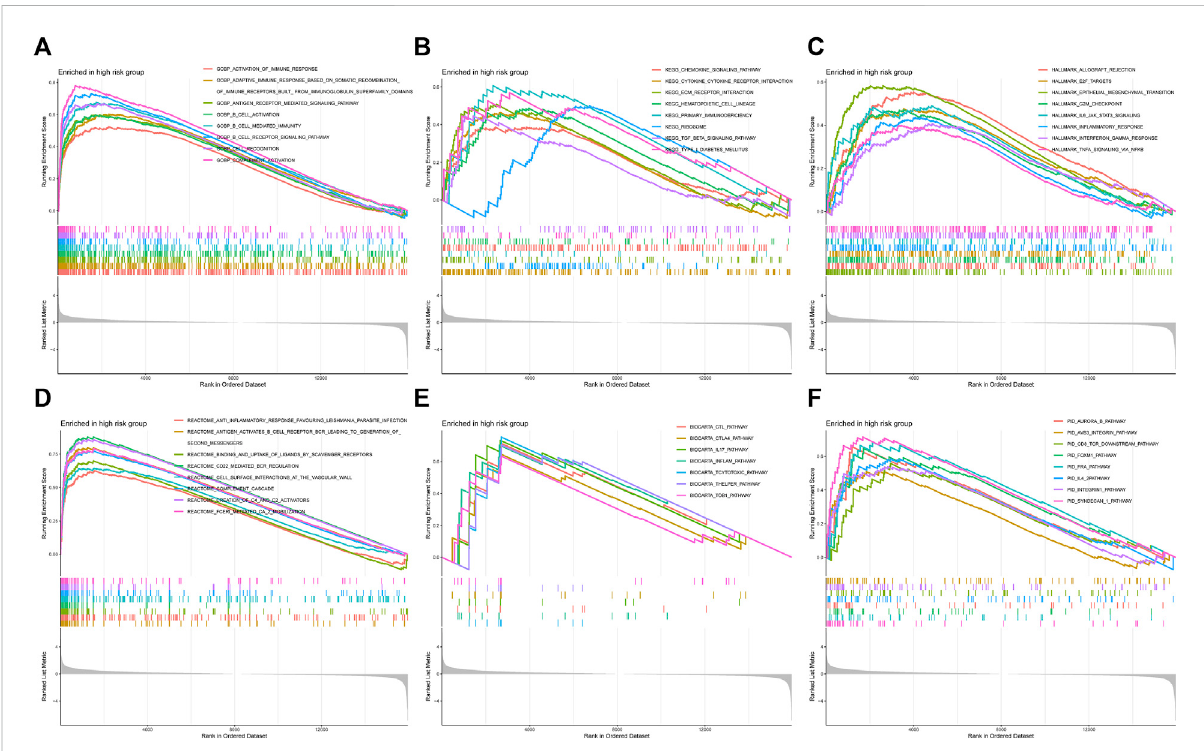
FIGURE 10 Functional enrichment analysis with GSEA. (A) Gene Ontology Biological Process (GOBP), (B) Kyoto Encyclopedia of Genes and Genomes (KEGG), (C) Hallmark, (D) Reactome, (E) BioCarta, and (F)